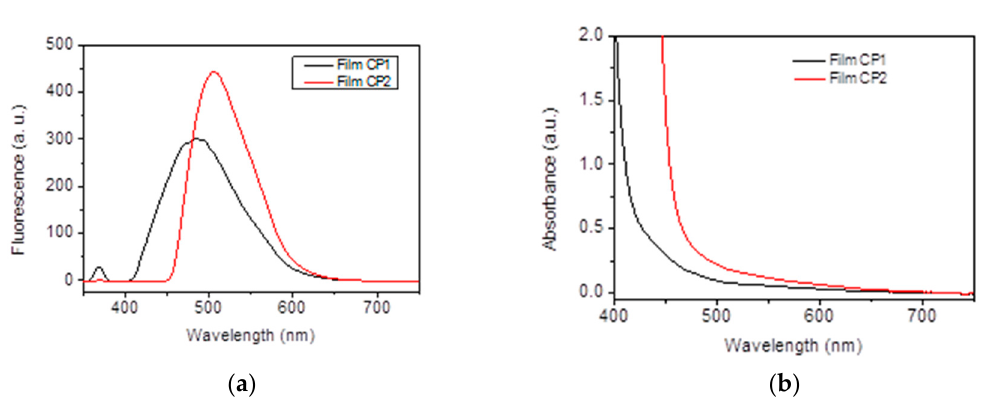
Figure 2. ( a ) Emission spectra of films of CP1 and CP2 with under an excitation wavelength of λ ex = 370 nm. (maximum emission λ em Film CP1 = 485 nm. λ em Film CP2 = 505 nm). ( b ) Absorbance spectra of CP1 and CP2 films.